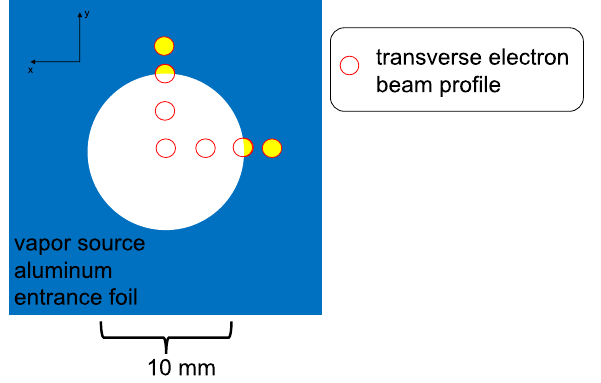
FIG. 2. Schematic drawing of the vapor source entrance. Examples of electron beam transverse positions at the entrance aperture during the horizontal and vertical scans are shown. The yellow areas mark the fraction of the beam interacting with the material, i.e., beam loss. The drawing is not to scale.